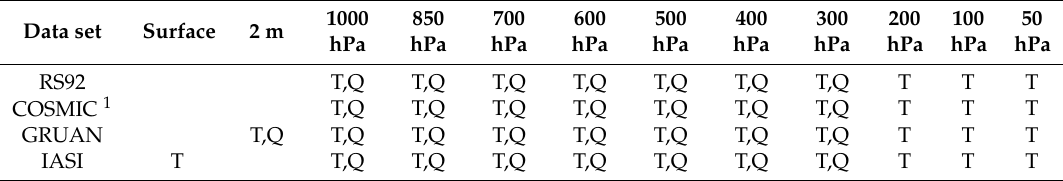
Table 2. Pressure levels where comparisons with high-resolution infrared radiation sounder (HIRS) retrievals are available and performed. T and Q indicate temperature and specific humidity comparisons, respectively.